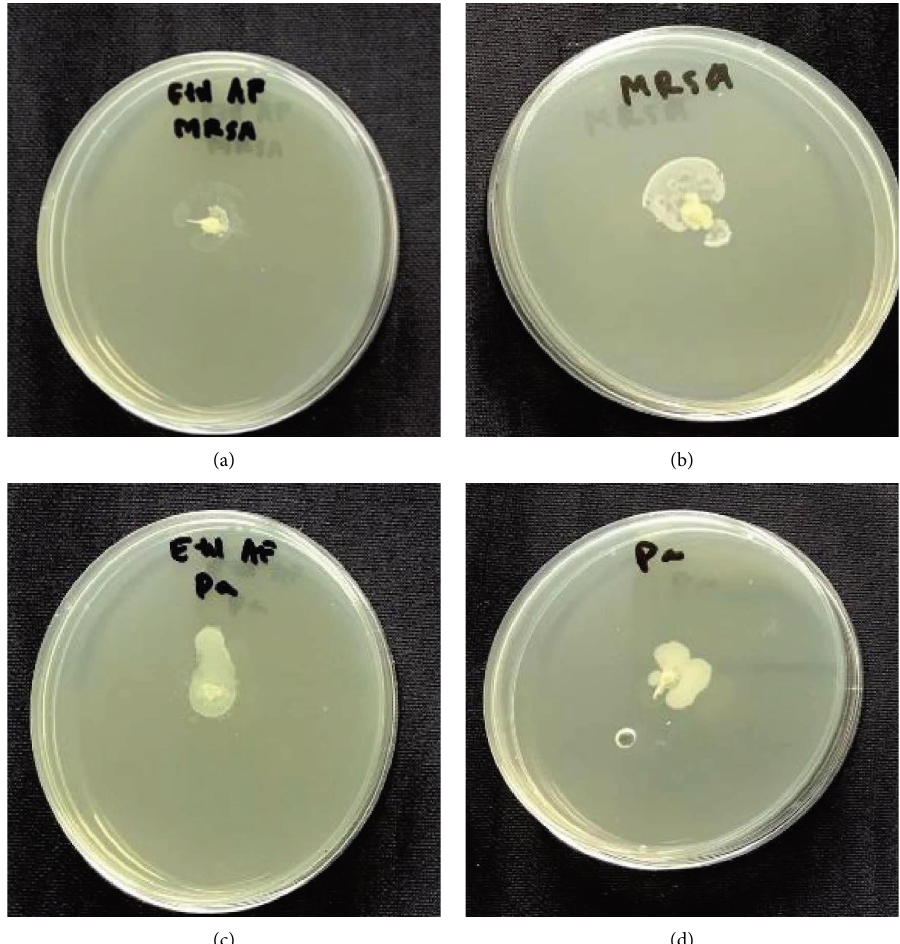
Figure 7: Swarming motility activity of EAFVA on (a) MRSA; (b) negative control MRSA; (c) P.aeruginosa ; and (d) negative control P.